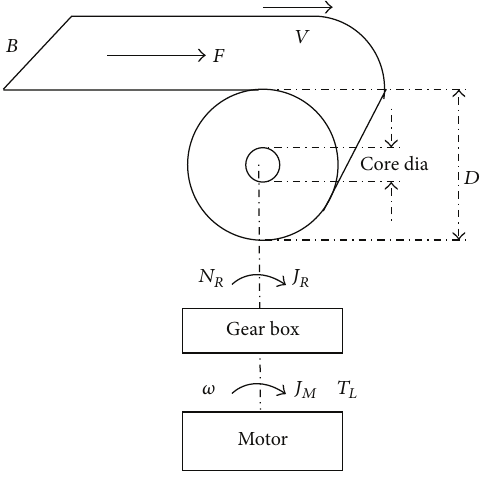
Figure 1: Working process of hot rolling